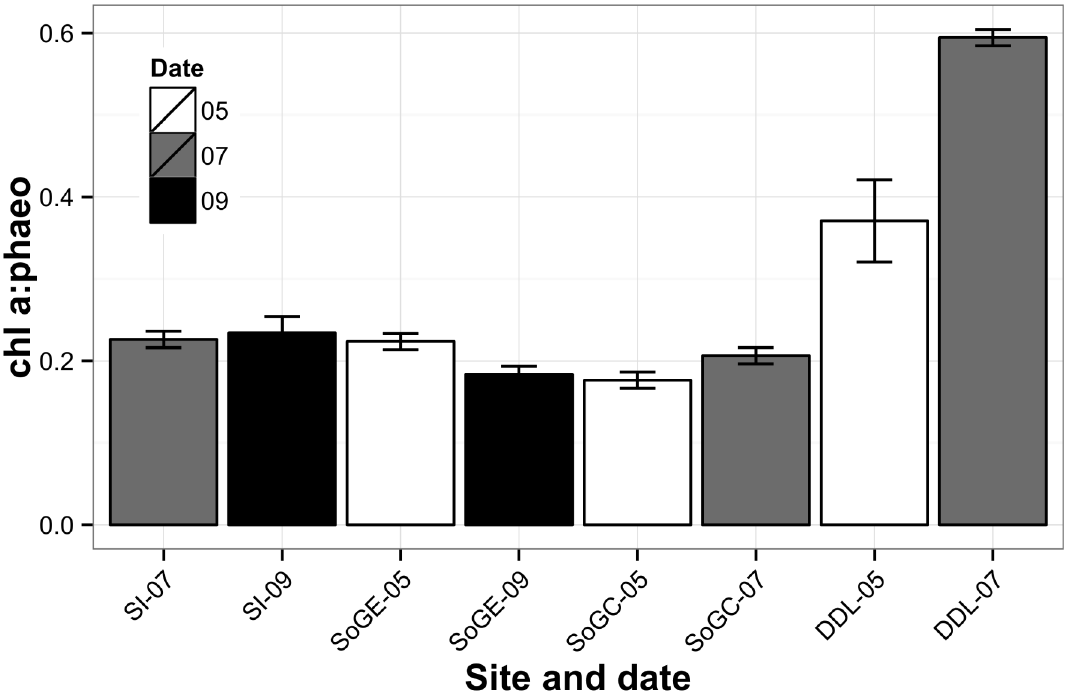
Fig 6. Sediment chlorophyll a :phaeopigment ratio ( ± SE) measured at each location in the Salish Sea. White bars represent fluxes measured in May 2011, grey bars represent fluxes measured in July 2011, and black bars represent fluxes measured in September 2013.